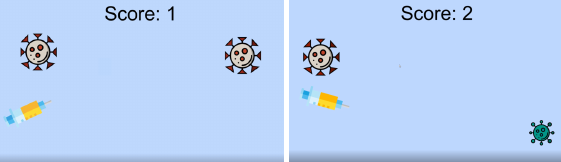
Figure 10. Some keyframes in temporal sequence from the timeline of Minigame2, with player’s scores bonus points proportionally to the duration of time the player gets invincible in the